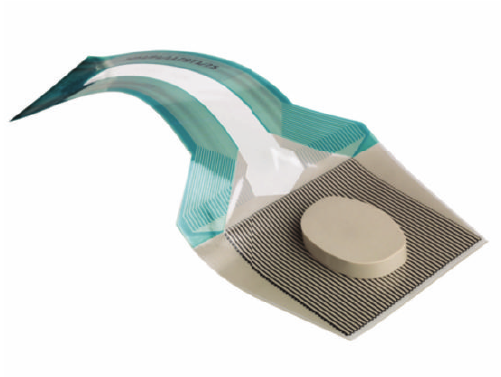
Figure 1: Tekscan pressure film used to measure contact pressures on the spacer. Note that during testing the film was placed above the